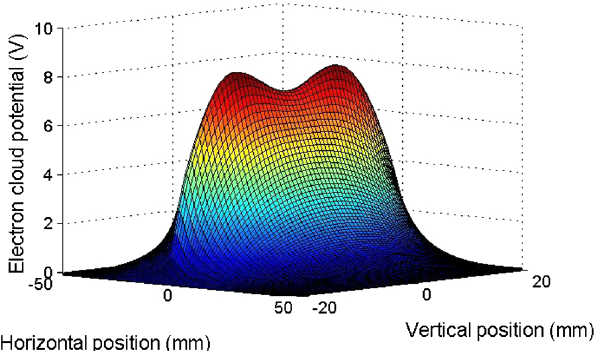
FIG. 9. Simulated potential of the electron cloud, seen by the last bunch of the train of 80 bunches, 5 × 10 10 ppb. The absolute value of the potential is plotted as a function of displacement from the beam center. The cloud potential decreases for small horizontal displacements and increases for small vertical